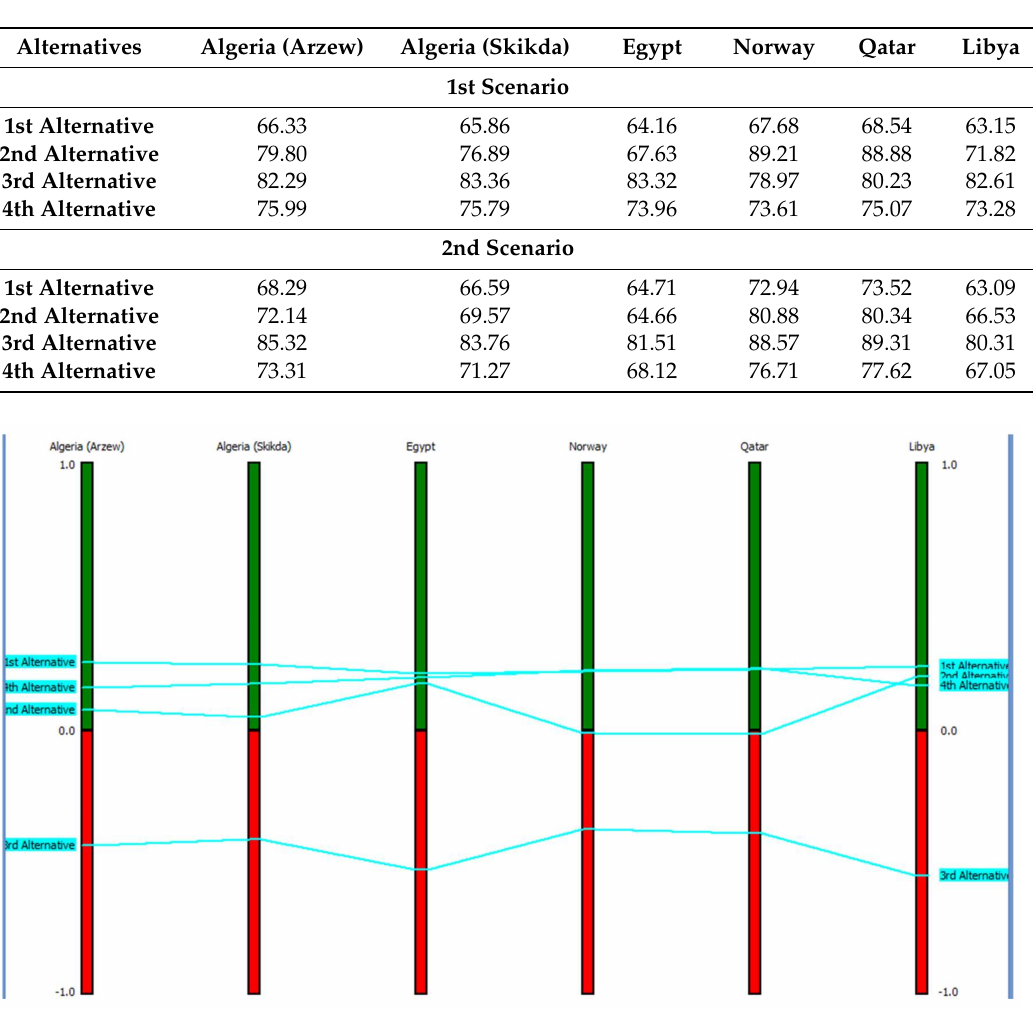
Figure 4. The results obtained from PROMETHEE II for the Basic Scenario.